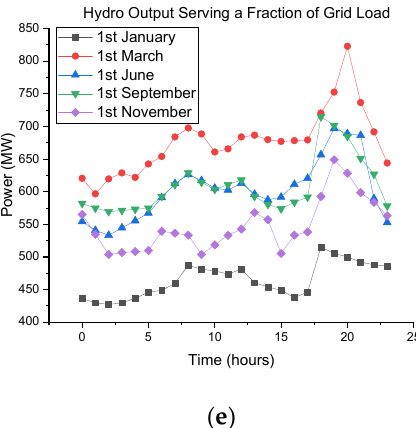
Figure 12. ( a ) Showing 3D June hydro-generation and discharge rate vs. time. ( b ) 3D June hydro-generation and reservoir level vs. time. ( c ) 3D November hydro-generation and discharge vs. time. ( d ) Day of month time series for hydro-generation vs. time. ( e ) Daily hydro output serving a fraction of grid load.